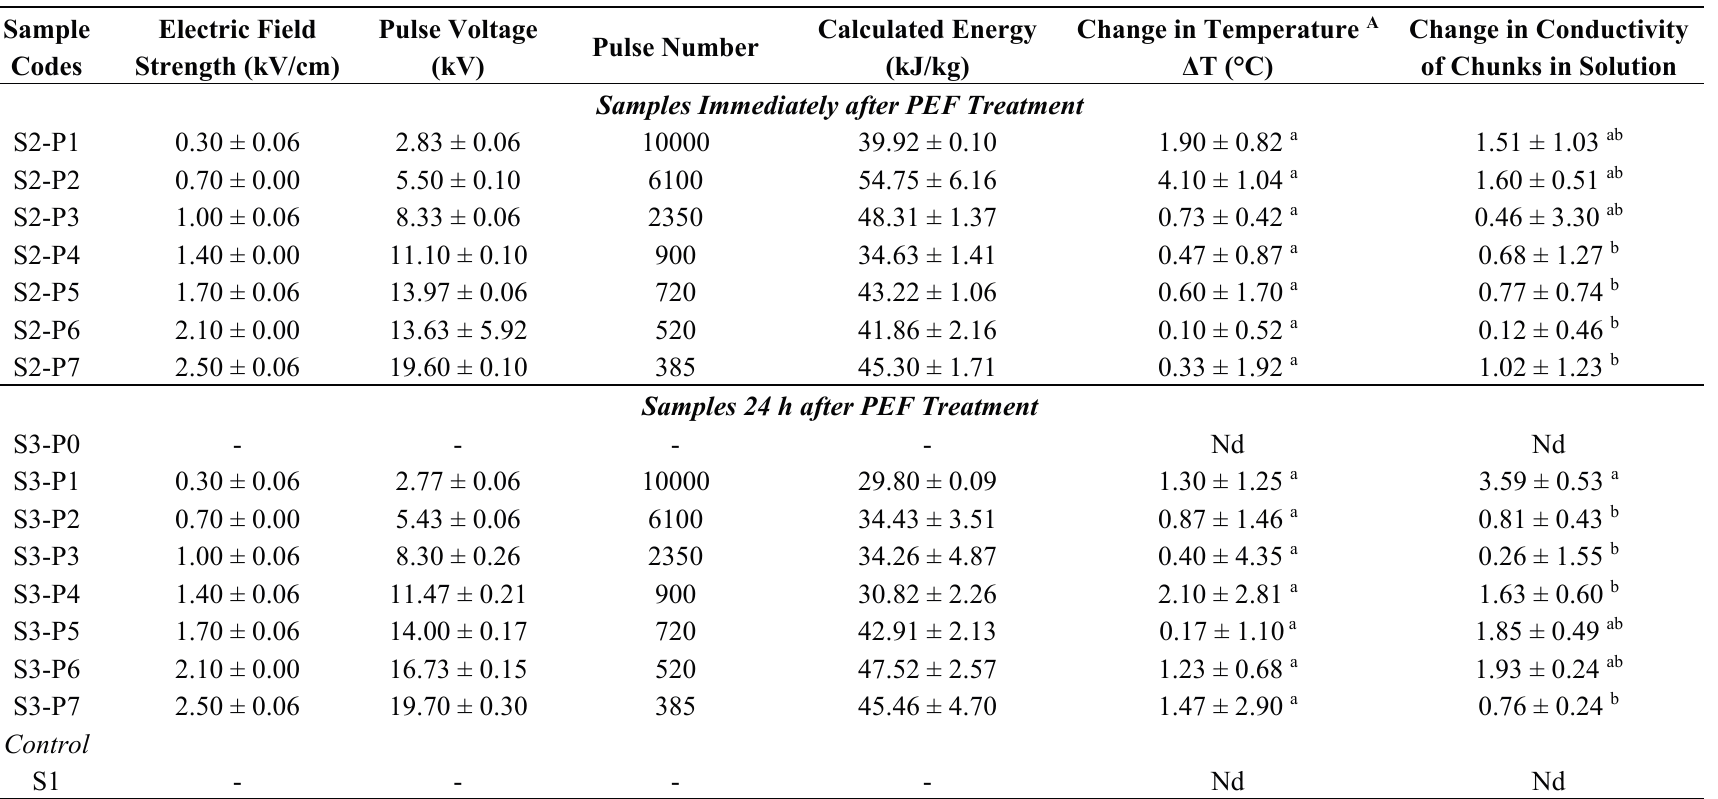
Table 2. Summary of PEF processing conditions and the processing impact on the changes in temperature and conductivity (Mean ± SD).